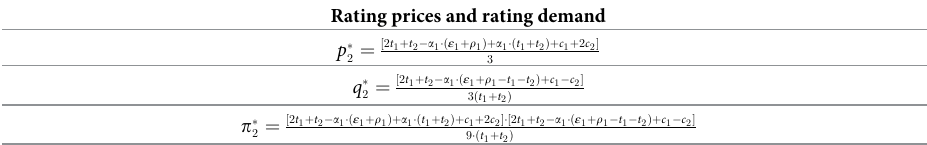
Table 2. Short-term equilibrium solutions of GRAs. Rating prices and rating demand